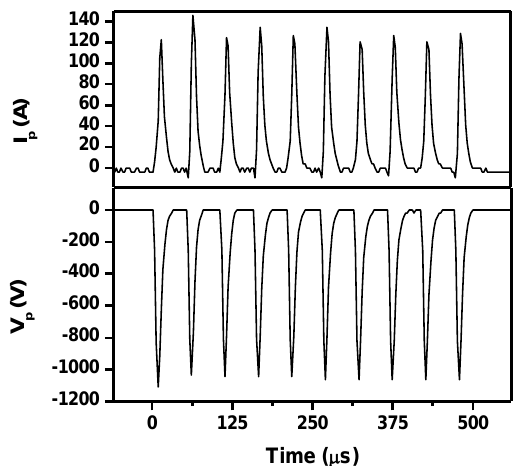
Figure 1. Representative HiPIMS DOMS discharge current and voltage oscillating waveforms for the W target used for the depositions.